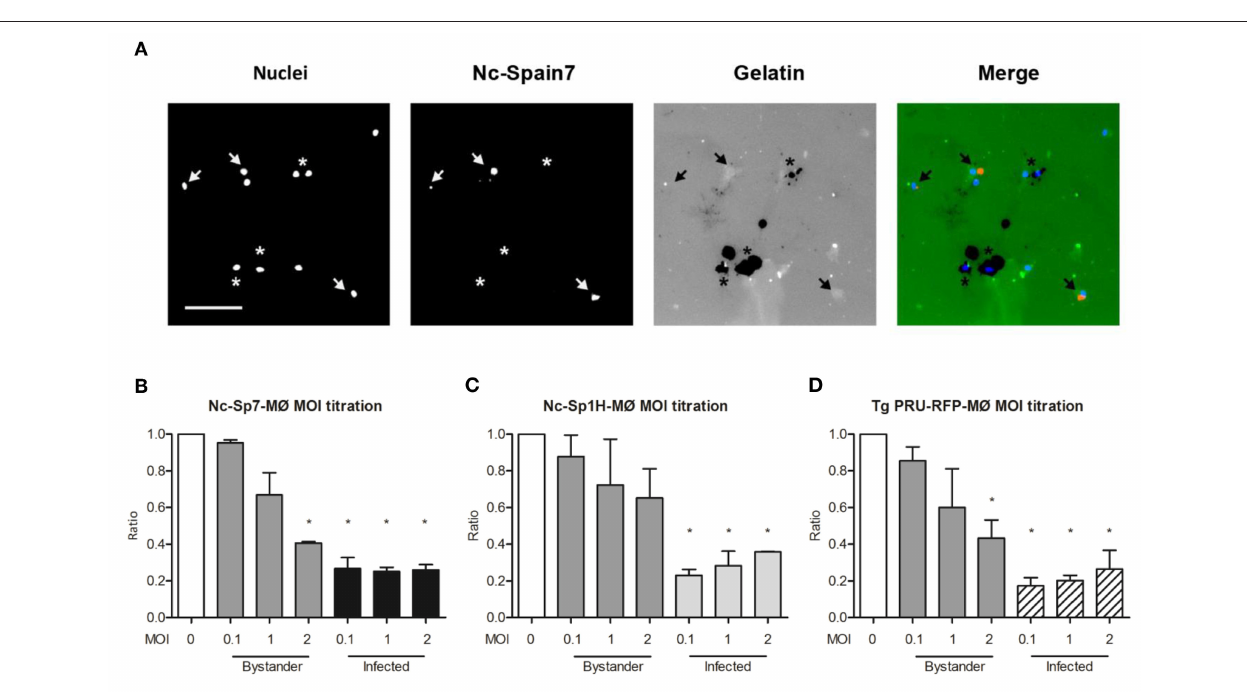
FIGURE 4 | Pericellular proteolysis of bovine MØs upon challenge with N. caninum and T. gondii . Gelatin degradation of MØs challenged with N. caninum Nc-Spain7 (Nc-Spain7-MØ), Nc-Spain1H (Nc-Spain1H-MØ), or T. gondii PRU-RFP ( T. gondii PRU-RFP-MØ) at the indicated MOIs. (A) Representative micrographs show MØ nuclear staining (Nuclei), Alexa-594-stained tachyzoites (Nc-Spain7), and fluorescent gelatin (Gelatin) with areas of gelatin degradation (absence of fluorescence signal). Arrowheads exemplify Nc-Spain7 - infected MØs with an absence of gelatin degradation. Asterisks exemplify non-infected by-stander MØs and co-localization with gelatin degradation. Scale bar represents 100 µ m. (B–D) Bar graphs show the mean ( ± SEM) relative gelatin degradation of unchallenged cells in CM (set to 1.0, MOI 0), non-infected by-stander cells (Bystander) and Neospora Spain7- (B) , Spain1H- (C) or T. gondii -infected (D) cells (Infected). The analysis comprised 160 FOVs and a total of 15.579 ± 1.087 (SEM) cells per condition from two independent experiments. Significant differences are indicated (* p <